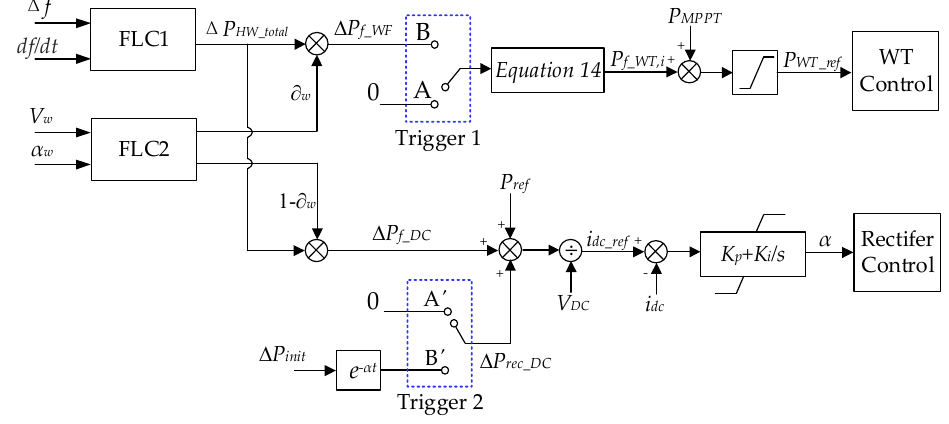
Figure 11. The control block-diagram of HWFRS.